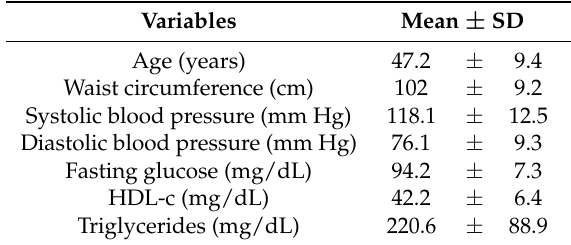
Table 1. Baseline metabolic syndrome characteristics of women ( n = 40).